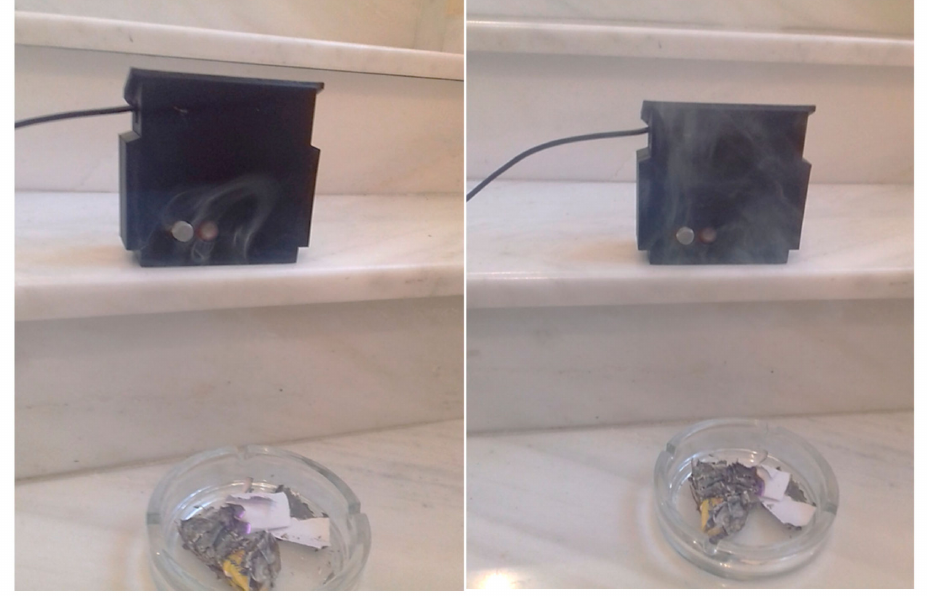
to 18:35:50 24 h/pm), and after the event (time period from 18:35:50 to 18:42:00 24 h/pm).